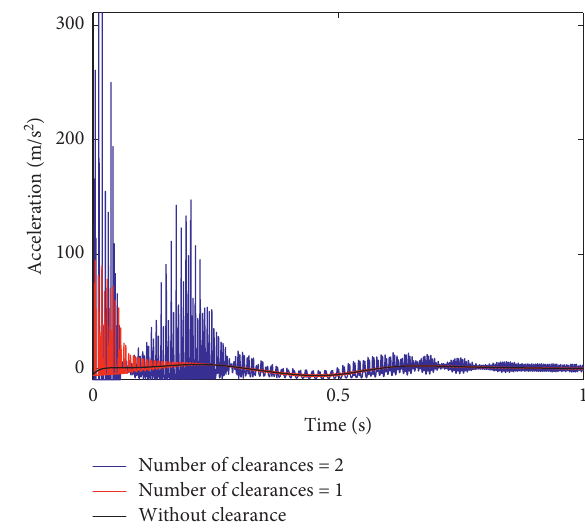
Figure 9: Displacement of the slider with different numbers of clearances.